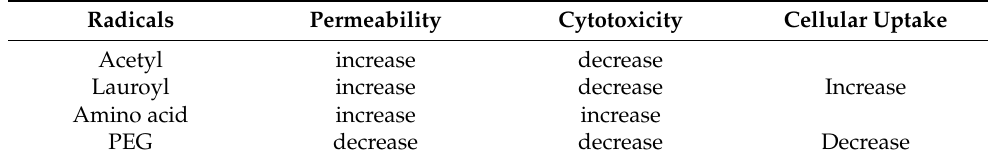
Table 3. PAMAM dendrimer pathways to increase biocompatibility and reduce cytotoxicity [222].